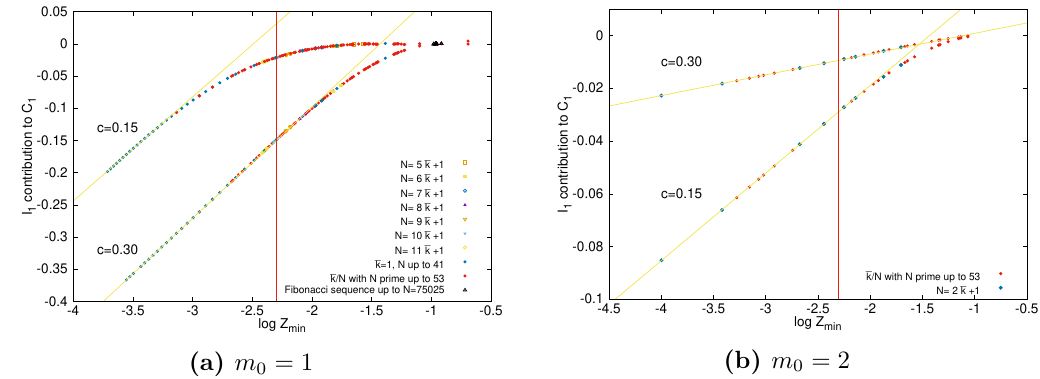
Figure 5. Z min -dependence of the contribution of I 1 to the one-loop matching constant C 1 . The red vertical line in the plots corresponds to Z min = 0 :